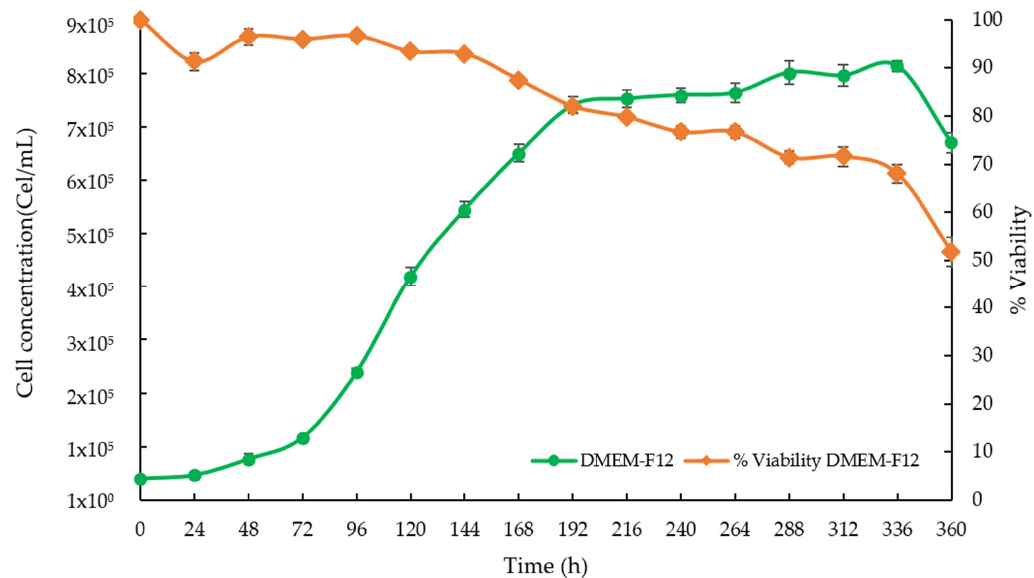
Figure 4. Growth kinetics of the HaCaT cell line in DMEM-F12 medium without scaffolds. The specific growth rate of the cell line in the DMEM-F12 supplemented with 10% SFB was 0.022 h −1 , with a doubling time of 32 h, values that coincide with those reported in the literature for the cell line of HaCaT keratinocytes [36]. The resulting morphology